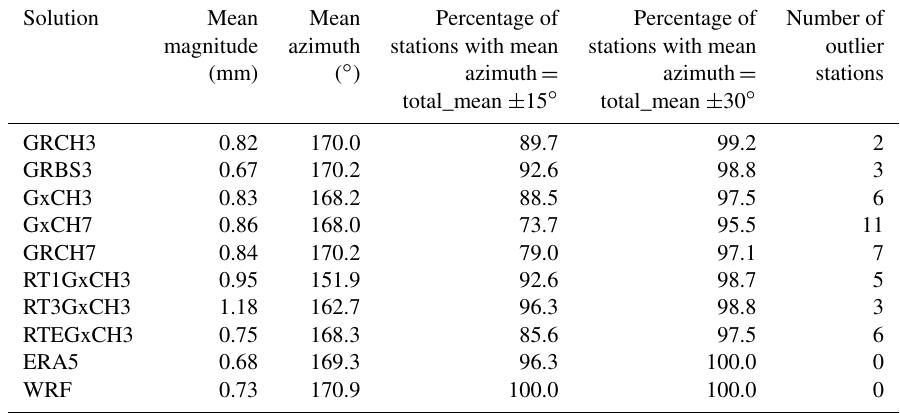
Table 2. Mean magnitudes and azimuth angles of tropospheric gradients from all individual GNSS variants of processing and NWMs ERA5 and WRF. Solution Mean Mean Percentage of Percentage of Number of magnitude azimuth stations with mean stations with mean outlier (mm) ( ◦ ) azimuth = azimuth = stations total_mean ± 15 ◦ total_mean ± 30 ◦ GRCH3 0.82 170.0 89.7 GRBS3 0.67 170.2